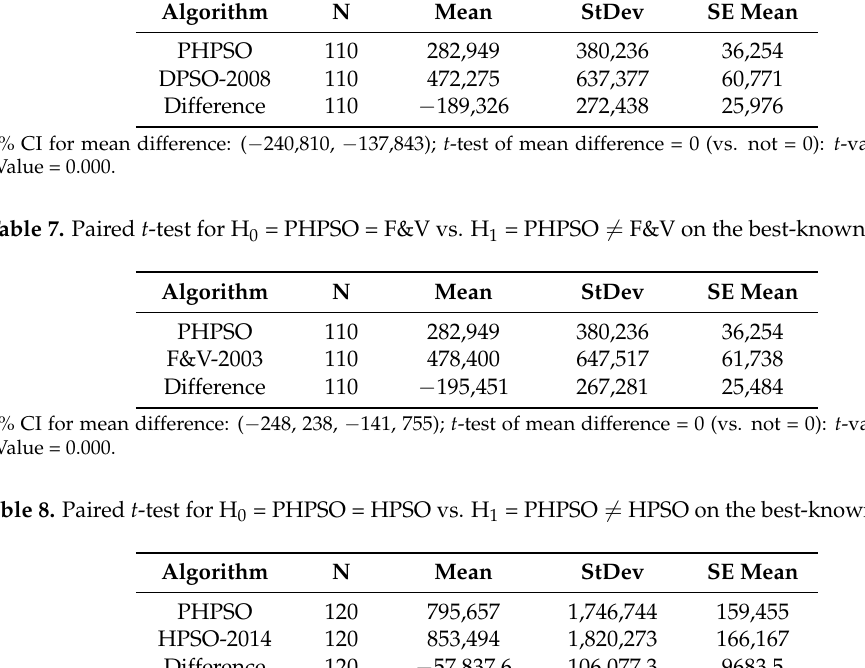
Table 6. Paired t -test for H 0 = PHPSO = DPSO vs. H 1 = PHPSO (cid:54) = DPSO on the best-known solutions Algorithm N